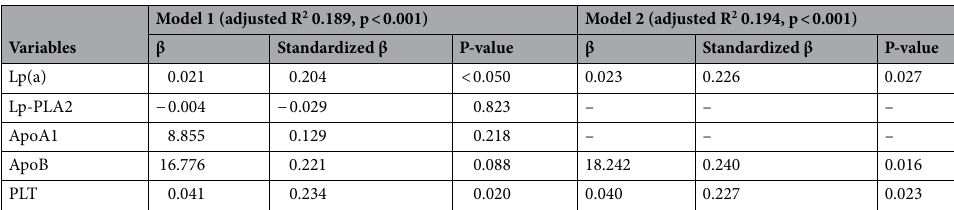
Table 2. The results of the multivariate linear regression analysis regarding the association of AA-induced AAR and characteristics. AA arachidonic acid, AAR average aggregation rate, Lp ( a ) lipoprotein a, Lp-PLA2 lipoprotein-associated phospholipase A2, ApoA1 apolipoprotein A1, ApoB apolipoprotein B, PLT platelet counts.